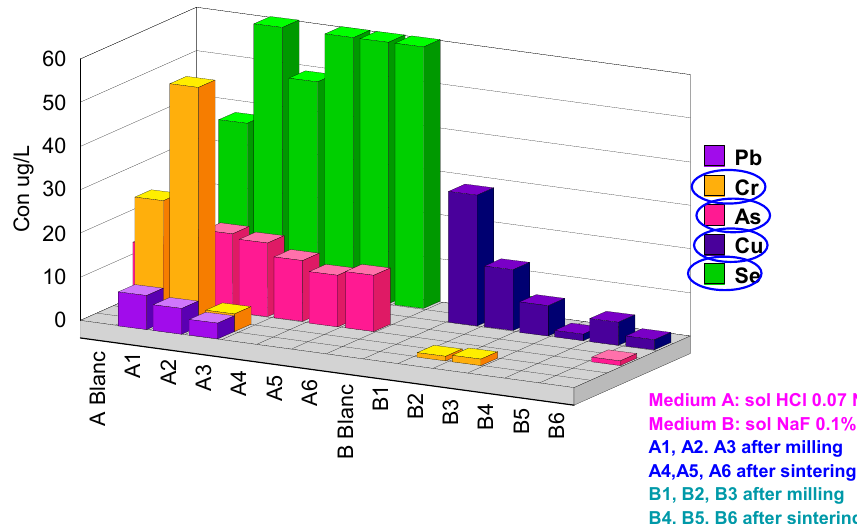
Figure 8. Cations released in the tenth of μ g/L scale.